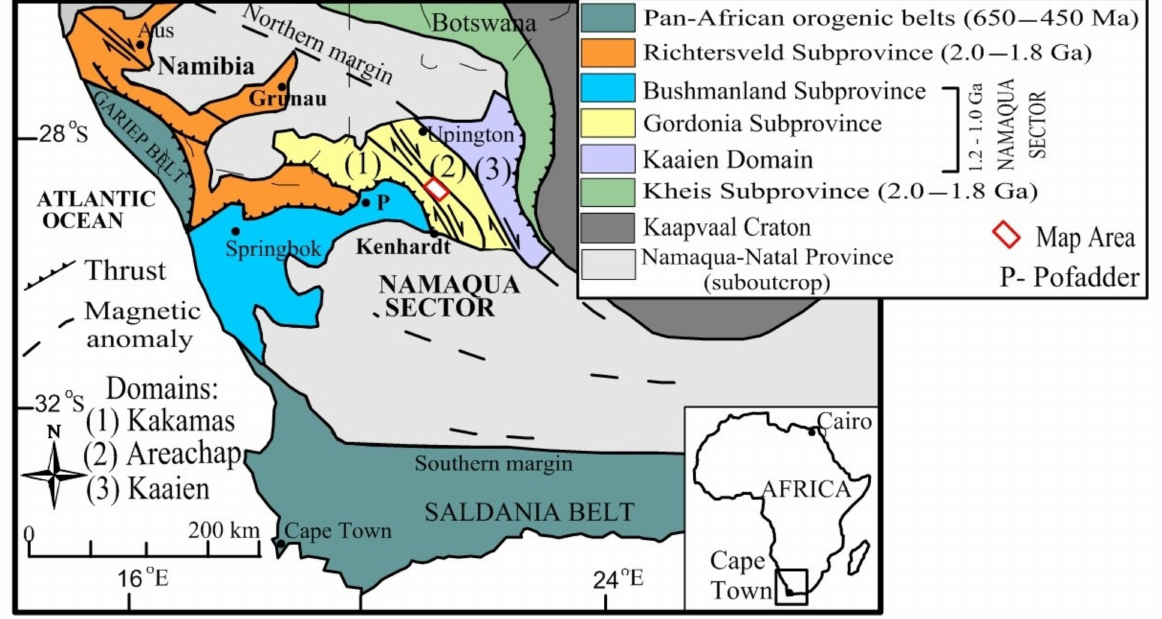
Figure 1. Geological subdivision of the Namaqua Sector of the Namaqua-Natal Metamorphic Province in South Africa (modified after [13]). The position of the study area is indicated. Abbreviations: